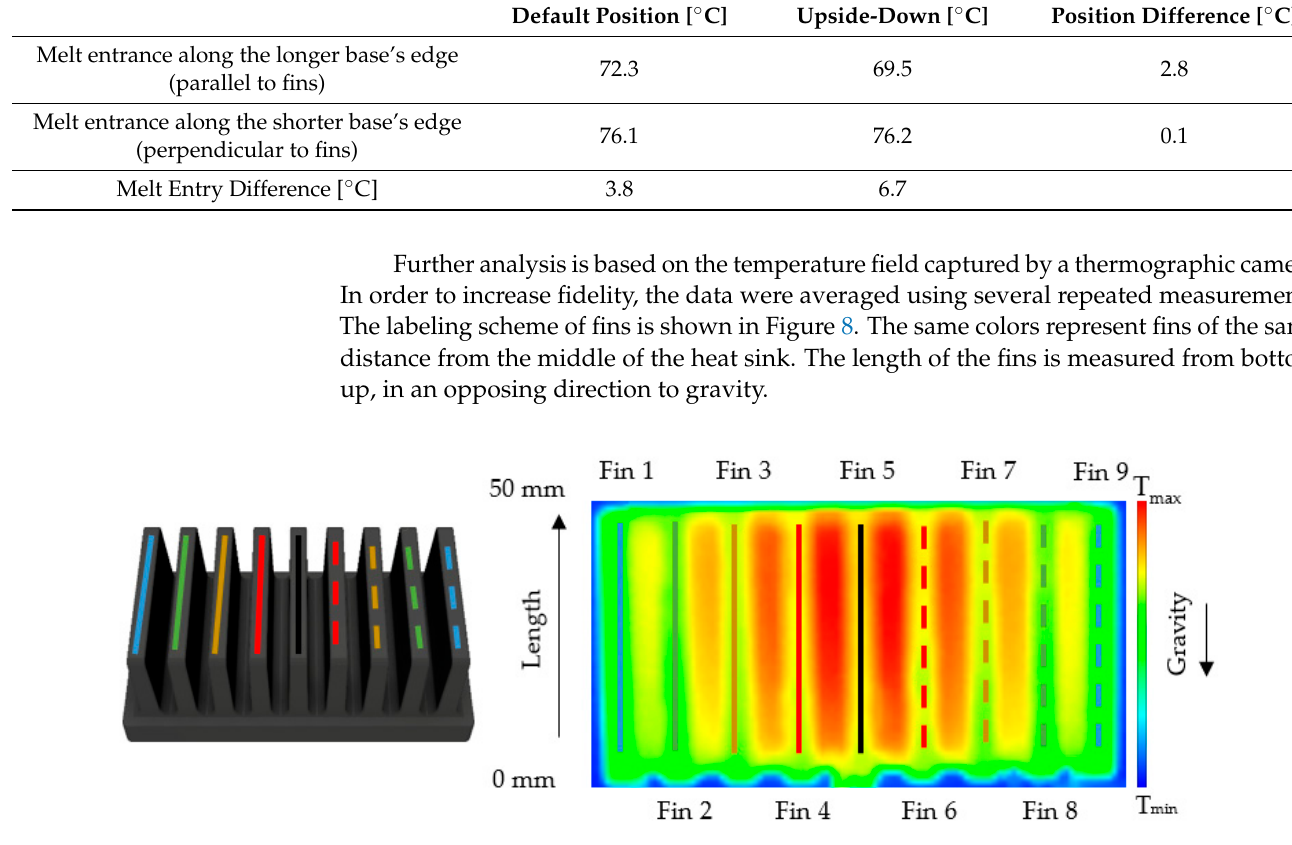
Figure 8. Labelling system of the heat sink’s fins, ( left )—model of the heat sink, ( right )—thermal image. Comparison of the average fin temperatures is shown in Figure 9. The chart compares the “upside-down” position of the heat sink made with the melt flow parallel to the fins, with the heat sink made with the melt flow perpendicular to the fins.